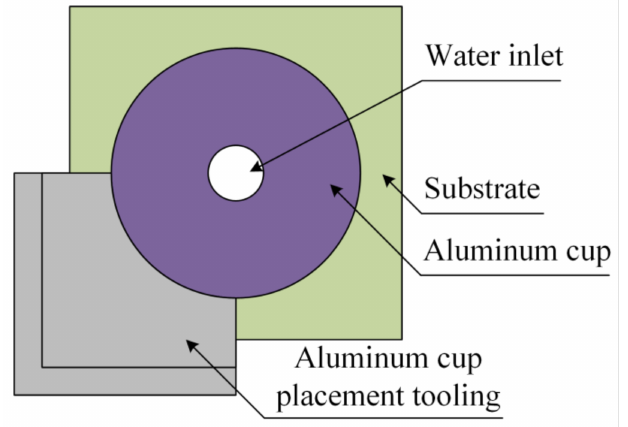
Figure 7. Placement of aluminum cup.